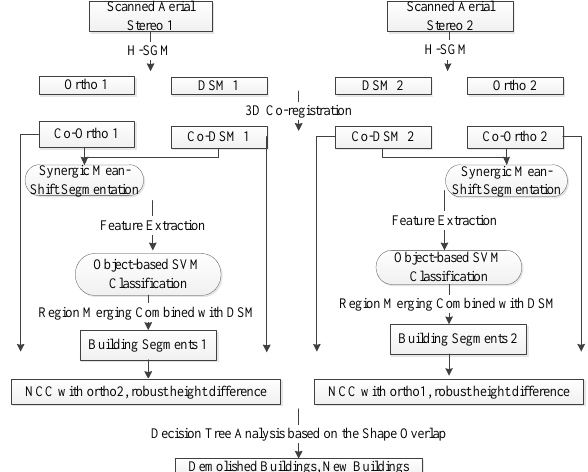
Figure 1. The workflow of the proposed method.